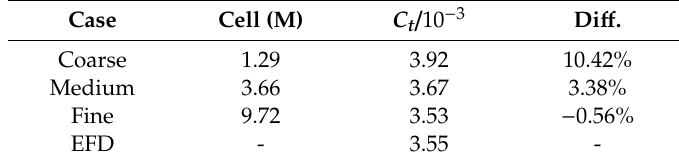
Table 6. The total resistance coe ffi cients of di ff erent time steps of the 1:31.6 scaled model. Case ∆ t / s C t / 10 − 3 Di ff . Coarse